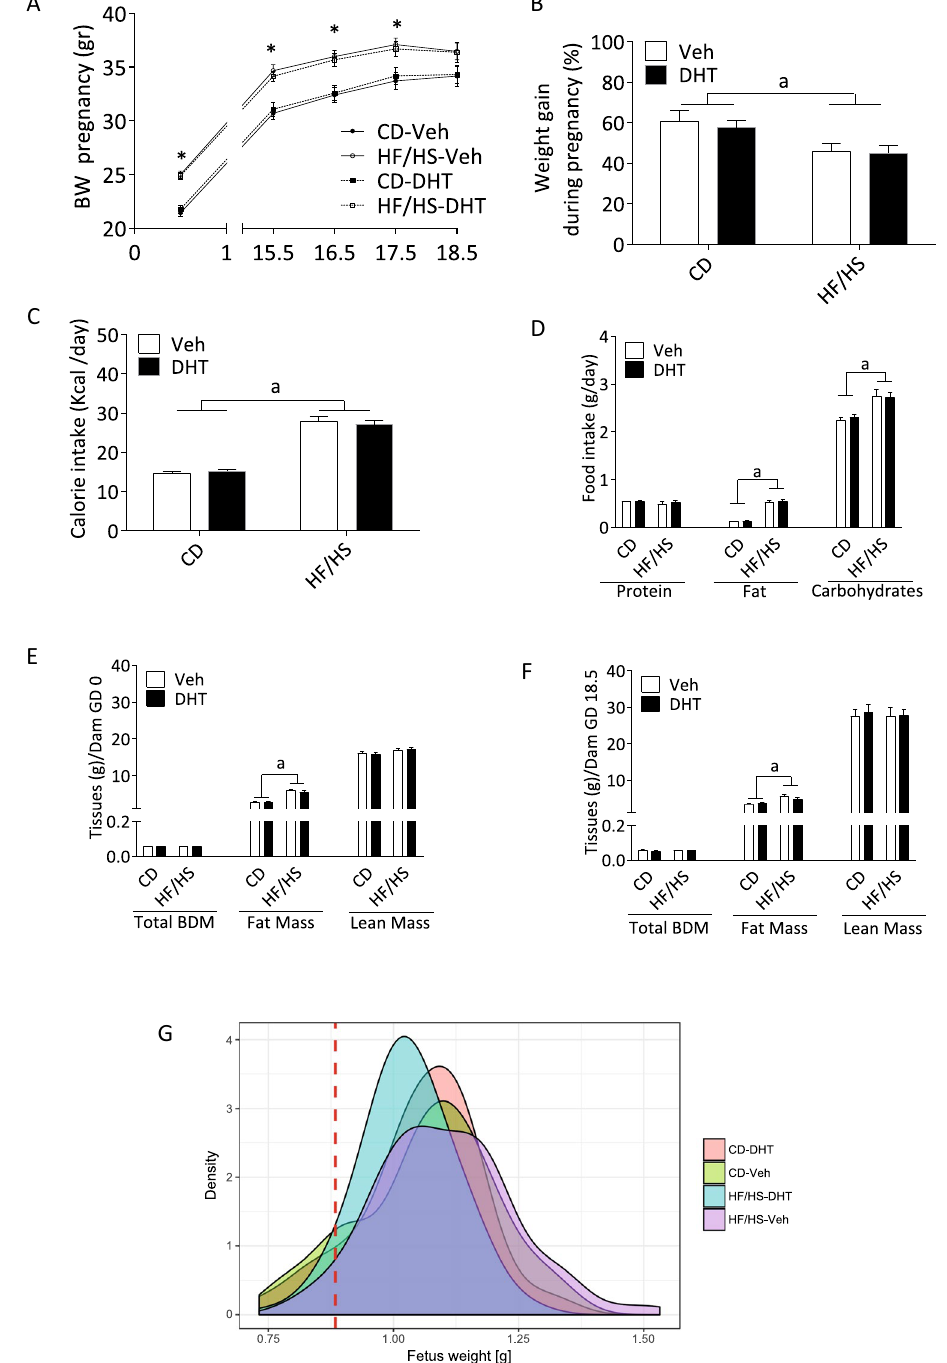
Figure 1. Maternal body weight development, calorie intake and body composition ( A ) Body weight gain during pregnancy; ( B ) Percentage of weight gain during pregnancy (CD-Veh, n = 12–13; HF/HS-Veh, n = 12–13; CD-DHT, n = 11–12; HF/HS-DHT, n = 14). ( C ) Caloric intake (Kcal/day) (CD-Veh, n = 12–13; HF/ HS-Veh, n = 12–13; CD-DHT, n = 11–12; HF/HS-DHT, n = 14). ( D ) Food Intake (g/day) ( E ) DEXA the day before mating (GD0) and ( F ) DEXA GD18.5 (CD-Veh, n = 5; HF/HS-Veh, n = 5; CD-DHT, n = 4; HF/HS-DHT, n = 4). ( G ) Distribution of fetal weight across the groups. Values are means ± SEM. * P < 0.05 HF/HS vs CD-Veh and HF/HS-DHT vs CD-Veh or CD-DHT, a = Main effect of diet p <